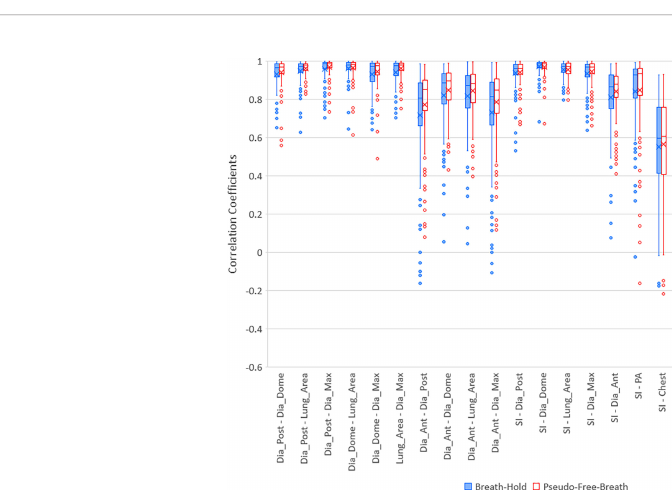
FIGURE 3 | Boxplots of selected correlation coef fi cients between two of 9 parameters, PA, SI, Dia_Post, Dia_Dome, Dia_Ant, Lung_Area, Dia_Max, Chest, and Belly for Breath-Hold and Pseudo-Free-Breath. Median and Average correlation coef fi cients are marked by horizontal line and “ x ” in each box, respectively. Interquartile range (IQR) is the difference between the 3 rd quartile (Q3, the upper side of each box) and the 1 st quartile (Q1, the lower side of each box). The upper whisker ends at maximum correlation coef fi cients while bottom whisker ends at Q1 – 1.5 * IQR. Any correlation coef fi cients smaller than Q1 – 1.5 * IQR are considered to be outliers and are displayed represented by